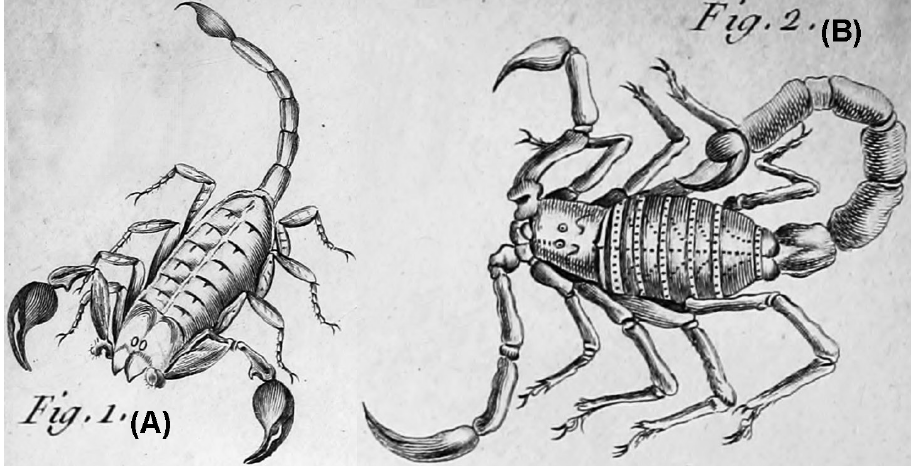
Figure 6. Original drawings of the habits of Scorpio europaeus Linnaeus, 1758 (A) and S. occitanus (B), according to Amoreux (1789b) reproduced from plate I of that work. These images are unfortunately rare- ly cited, as they are very informative regarding the reasoning of Amoreux while describing the new species. 1876, now a junior synonym of B. occitanus (Amoreux, 1789) (for further details